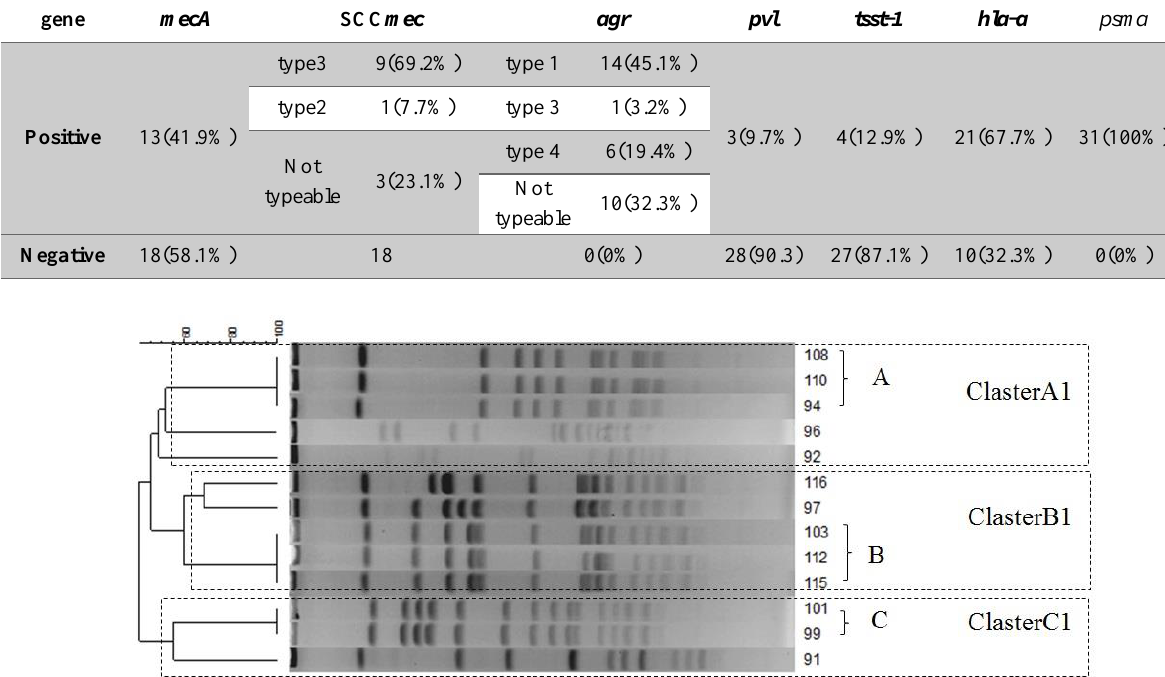
Figure1. PFGE analysis of CA-MRSA in current